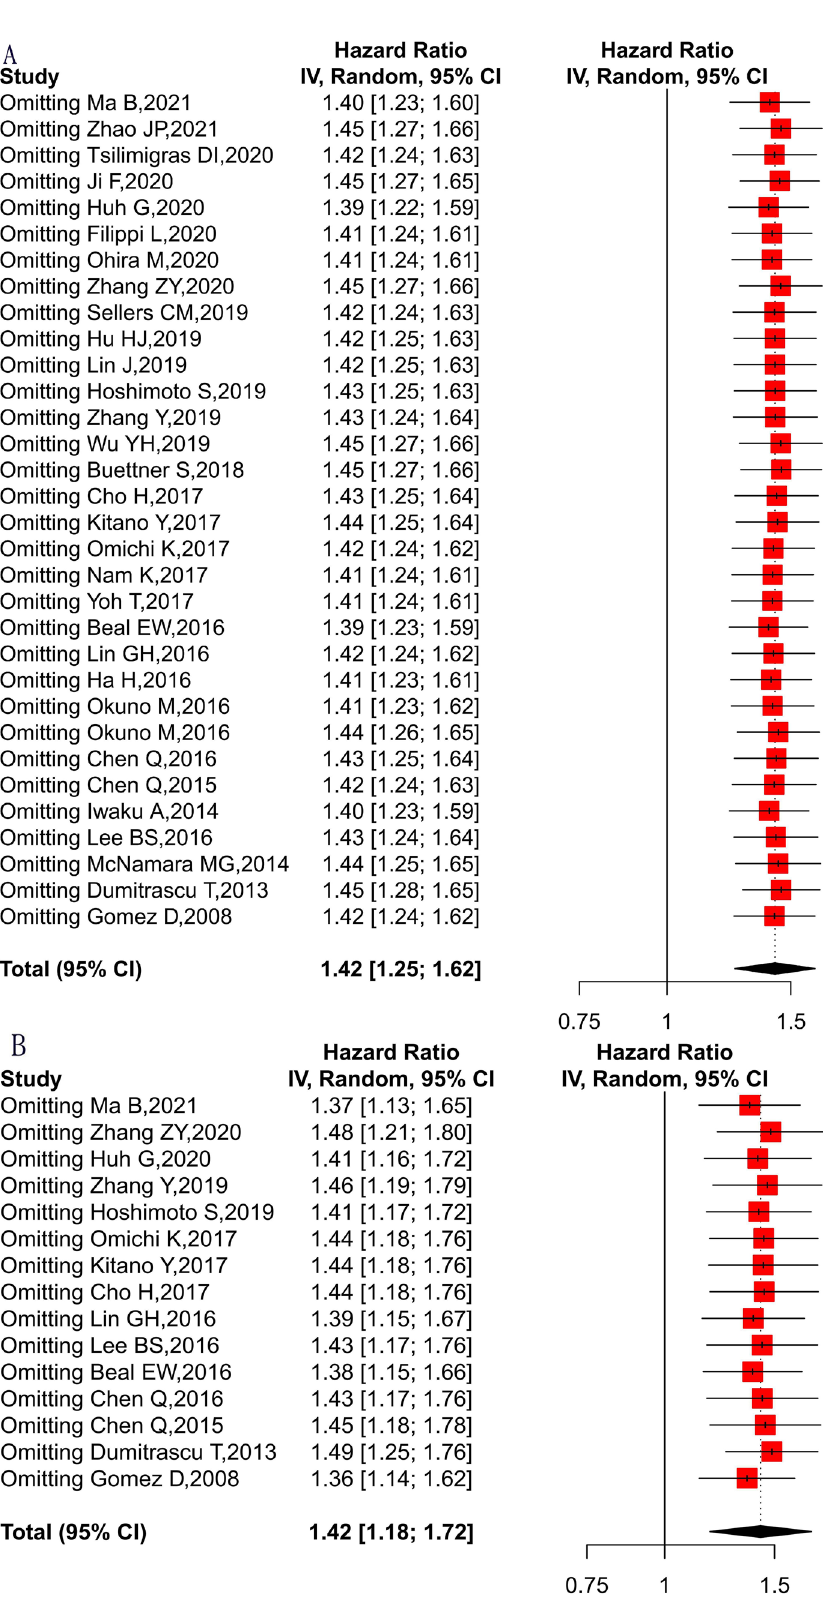
Figure 3. Sensitivity analyses of correlation between NLR and prognosis of CCA patients. Adopting a random effects model in sensitivity analyses, deleting each study in each turn, to further determine the robustness of the prognostic role of NLR. High NLR still displayed an unfavorable effect on OS(A) and